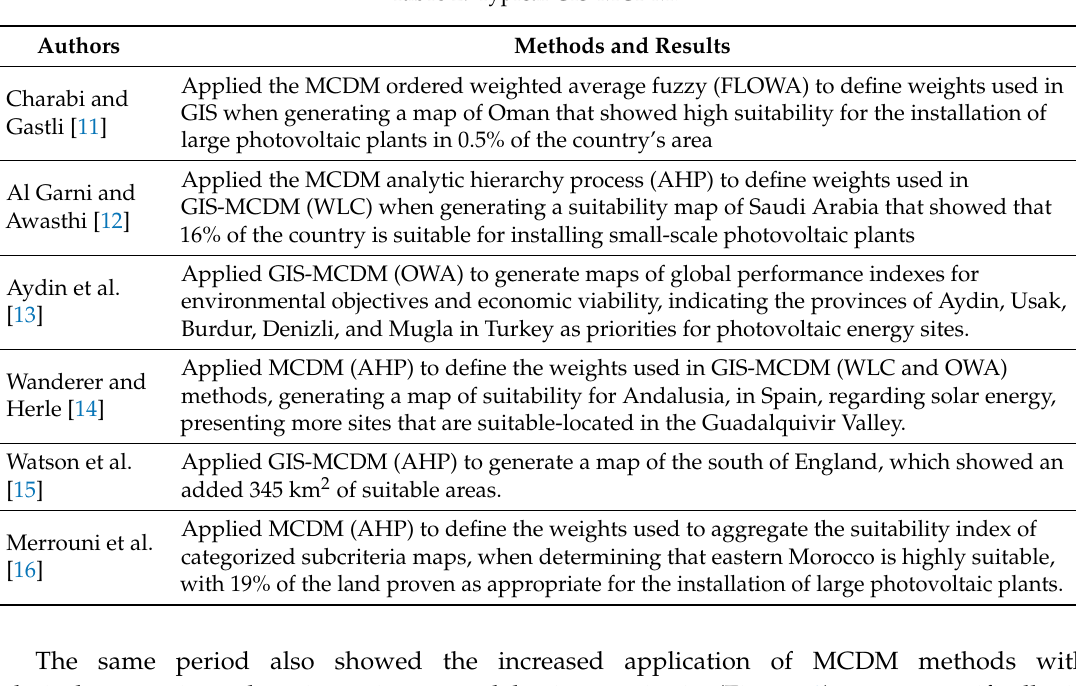
Table 2. Typical GIS-MCDM.